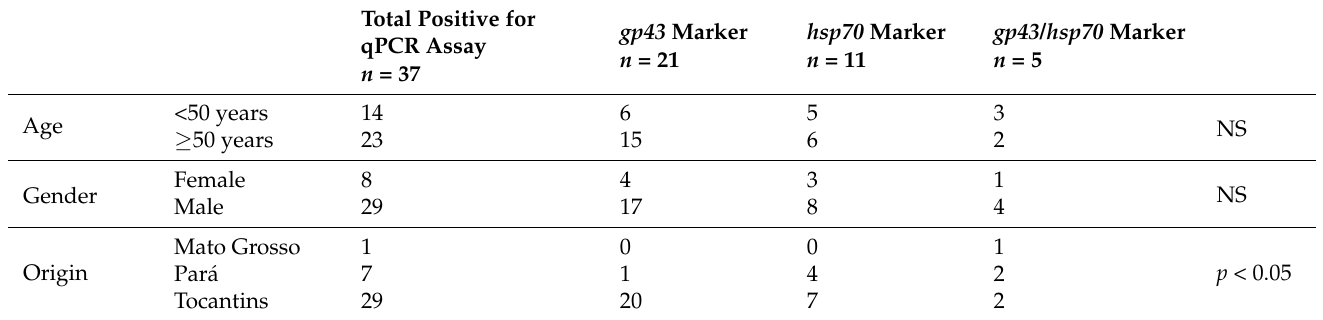
Table 2. Demographics of patients with paracoccidioidomycosis in Aragua í na, Tocantins, sorted by gene